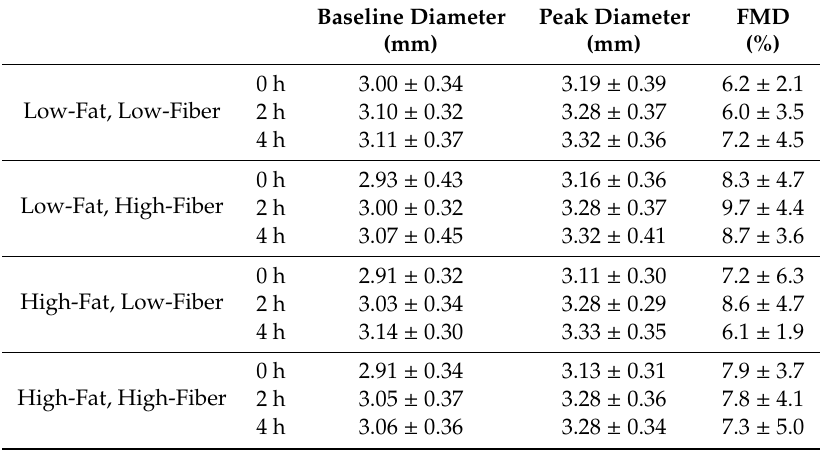
Table 8. Brachial artery diameters and flow-mediated dilation at each time point for the four meals.